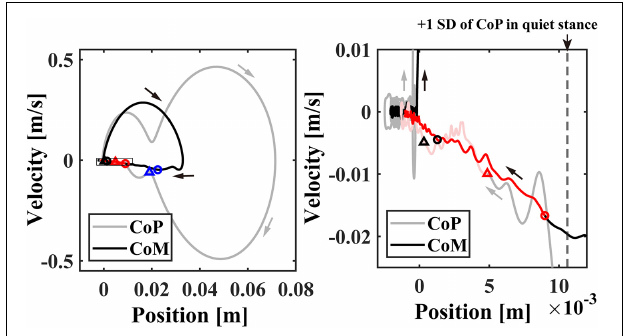
FIGURE 4 | The event-locked average of CoP/CoM profile (averaged across subjects) in the CoP/CoM-position vs. the CoP/CoM-velocity phase plane for –3 < t < 8 s. The small blue, red, and black circles plotted on the CoM (black line) trajectories in the left and/or right panels indicate the time instants of 0.5, 1.0, and 2.0 s, respectively. The triangles with the same colors indicate the corresponding time instants on the CoP (gray line) trajectories. The right panel is an enlargement of the rectangular region near the origin in the left panel. The time-duration with beta rebound (ERS) about 1.0 < t < 4.0 s with significantly large power was indicated by the red trajectories. The vertical dashed line in the right panel indicates the standard deviation of the postural sway during the quiet